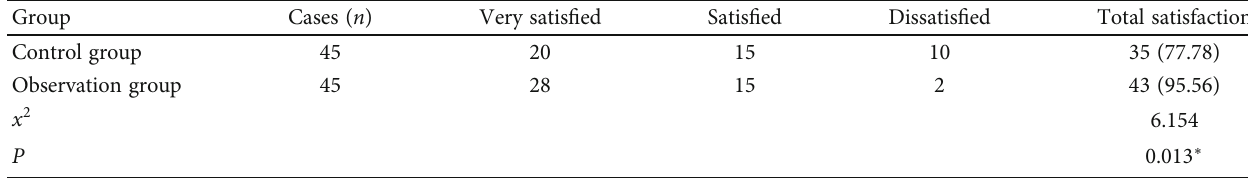
Table 5: Comparison of patient care satisfaction between the 2 groups ( n